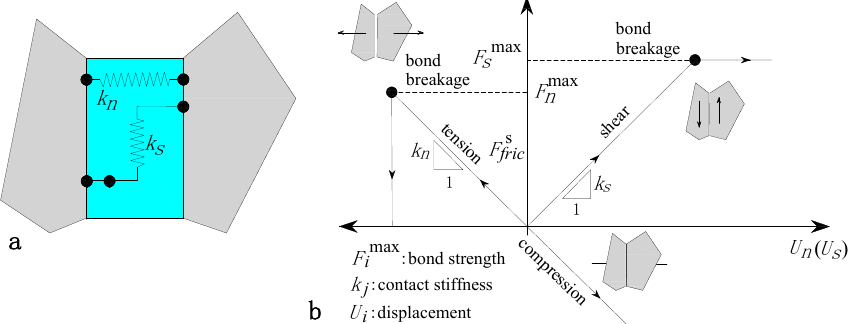
Figure 2. Contact constitutive model. ( a ) Normal and shear stiffness between blocks. ( b ) Constitutive behavior in terms of shear and tension ( i = s , n ) [19].